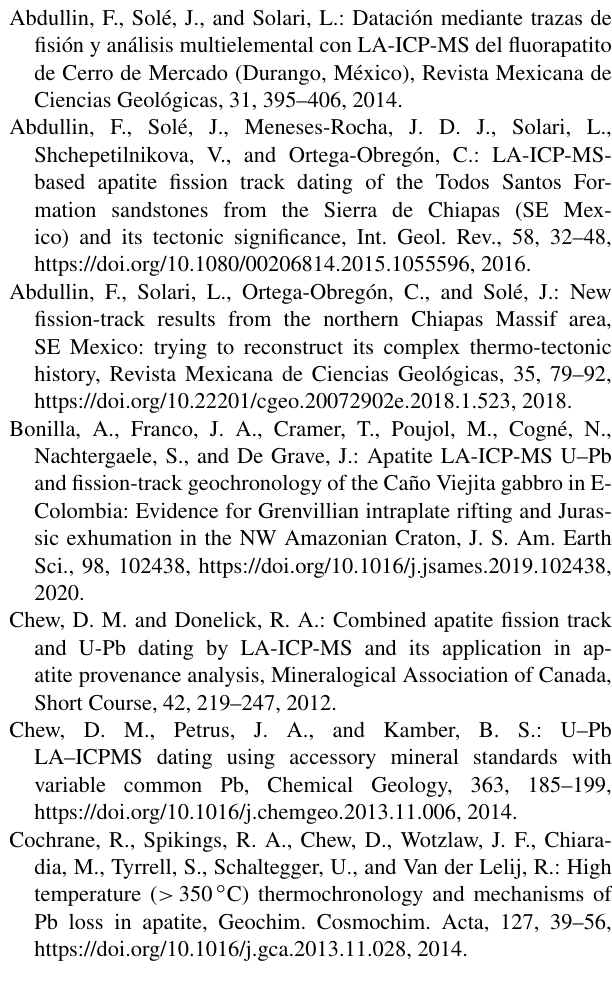
Figure 3. Plot showing the lower intercept U–Pb ages obtained on unetched and etched apatite